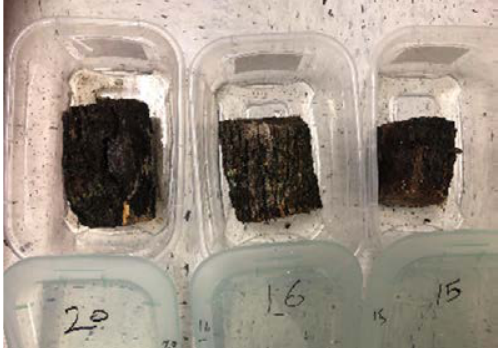
Fig. 1. Representation pieces of coarse woody debris of the same species collected from the field.